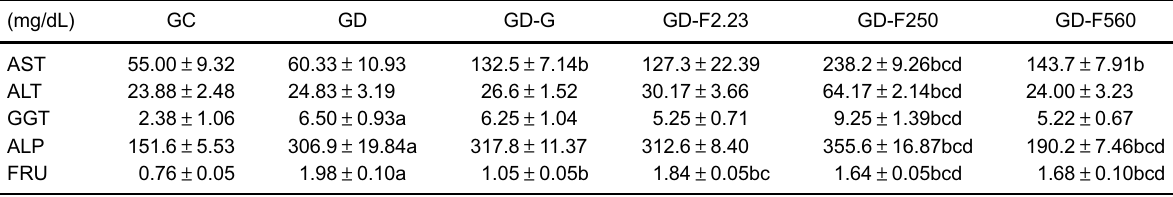
Table 2. Plasmatic markers of liver injury in mice from groups GC, GD, GD-G, GD-F2.23, GD-F250, and GD-F560. (mg/dL)